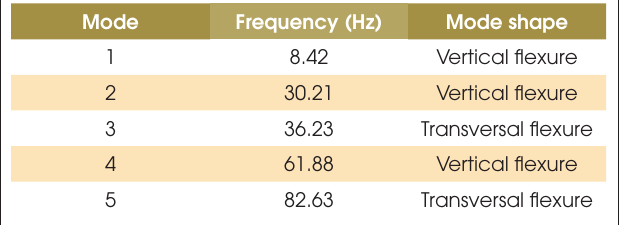
Table 1 – Natural frequencies obtained from the numerical